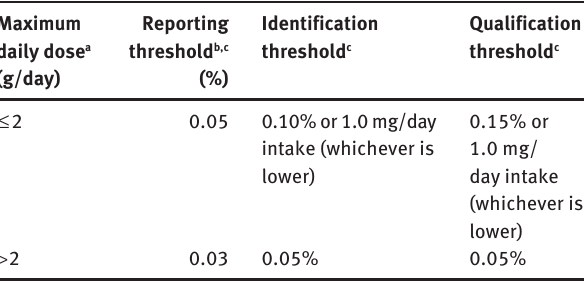
Table 1 Threshold for organic impurities [ICH Q-3A (R2)].